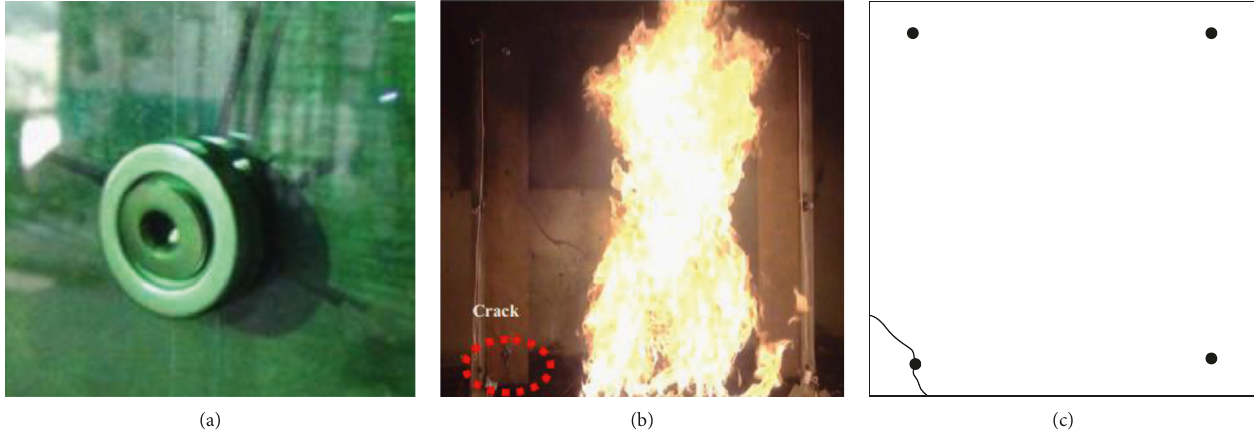
Figure 7: Fracture of point-fixed glass panels, in accordance with [60]. (a) Connector detail; (b) experimentally observed crack opening (front view); and (c) corresponding schematic